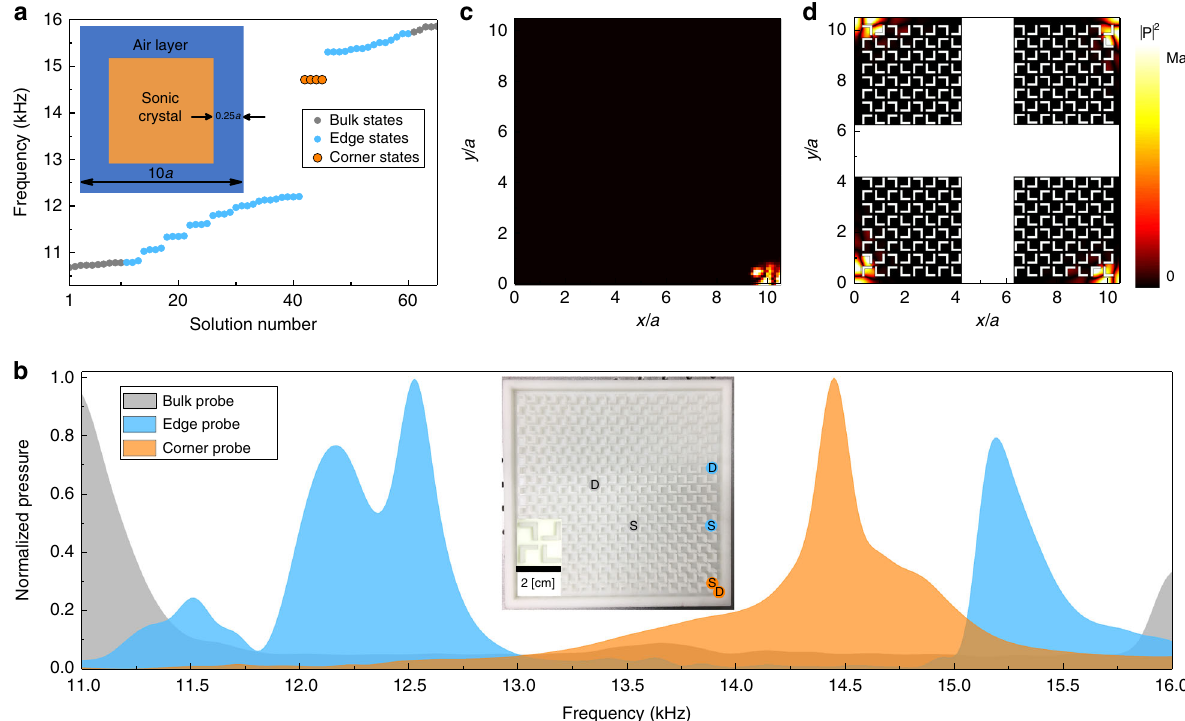
Fig. 4 Topological corner and edge states in the second band gap due to the anomalous quadrupole. a Calculated acoustic spectrum for a box-shaped fi nite structure consisting of 10 × 10 sonic crystal unit cells enclosed by hard-wall boundaries with an air channel of width 0.25 a separating them (see the inset for the structure illustration). b Frequency-resolved transmission spectra for three pump – probe con fi gurations: bulk probe, edge probe and corner probe. Inset: photo of the sample with a zoom-in photo of the unit-cell. Source ( “ S ” ) and detector ( “ D ” ) for each pump – probe con fi guration (including the bulk, edge, and corner probes) are marked in the inset using the same color as that of the corresponding transmission curve. c , d Measured and simulated acoustic pressure pro fi les of the corner states, respectively. Four degenerate corner states (related by the C 4 rotation) are shown in d , whereas only one of them is measured in c . Unit-cell geometry parameters are the same as that in Fig.